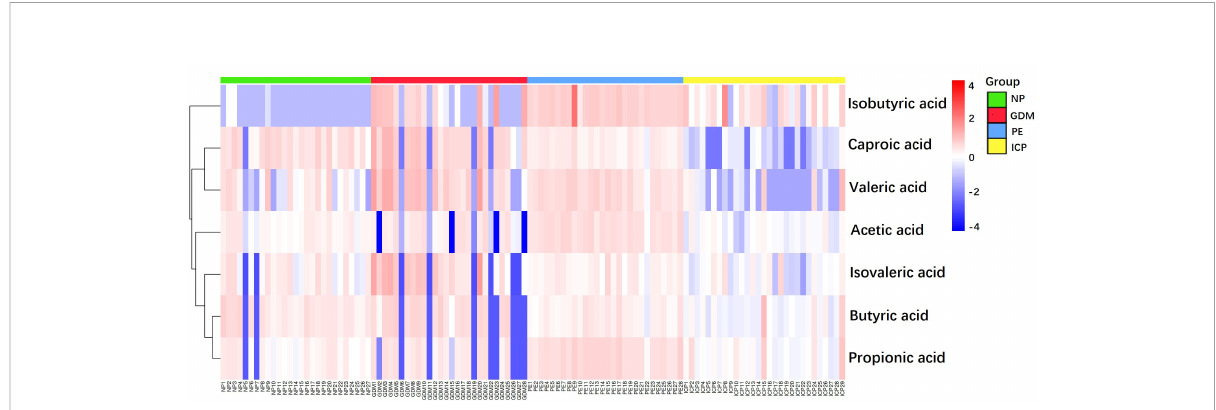
FIGURE 2 Heat map of SCFAs metabolites in pregnancy complications and NP groups. The magnitude of the relative amounts is shown by the difference in color, where the columns represent samples, and the rows represent SCFAs. Different colors represent different intensities, with red indicating relatively high kurtosis values and blue indicating relatively low kurtosis